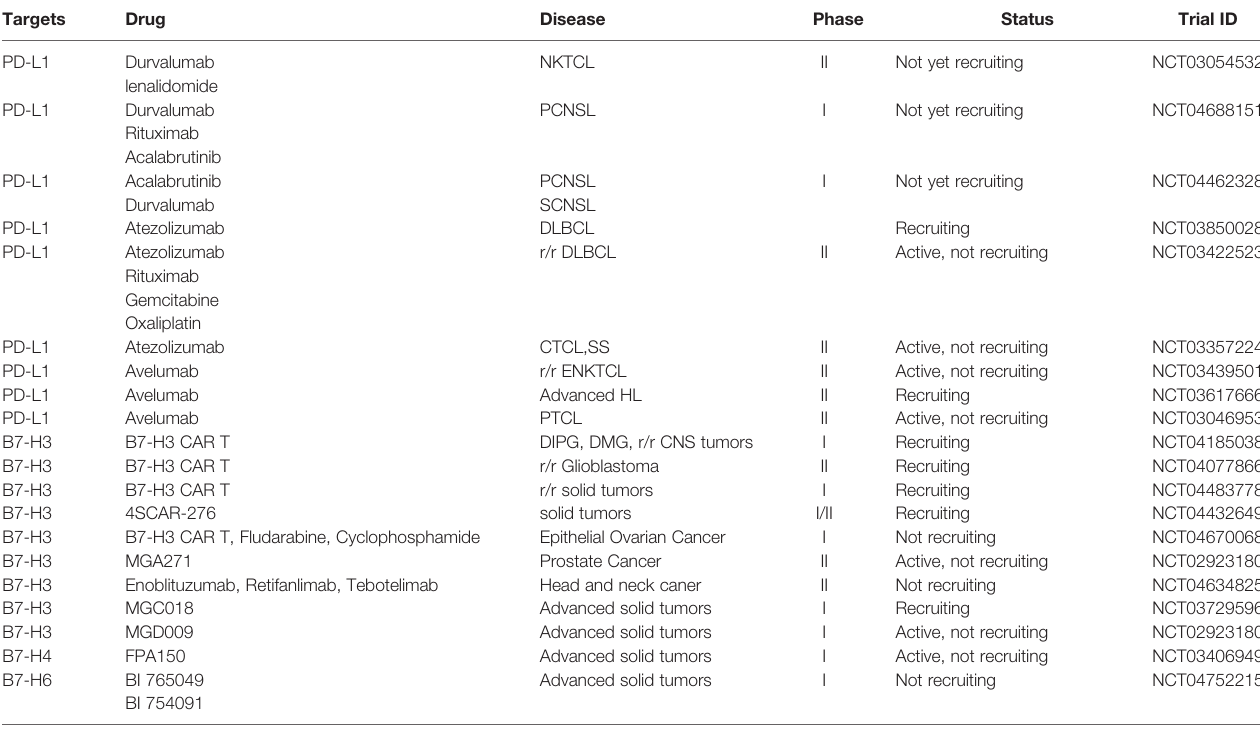
TABLE 2 | The ongoing clinical trials targeting on B7 family molecules.